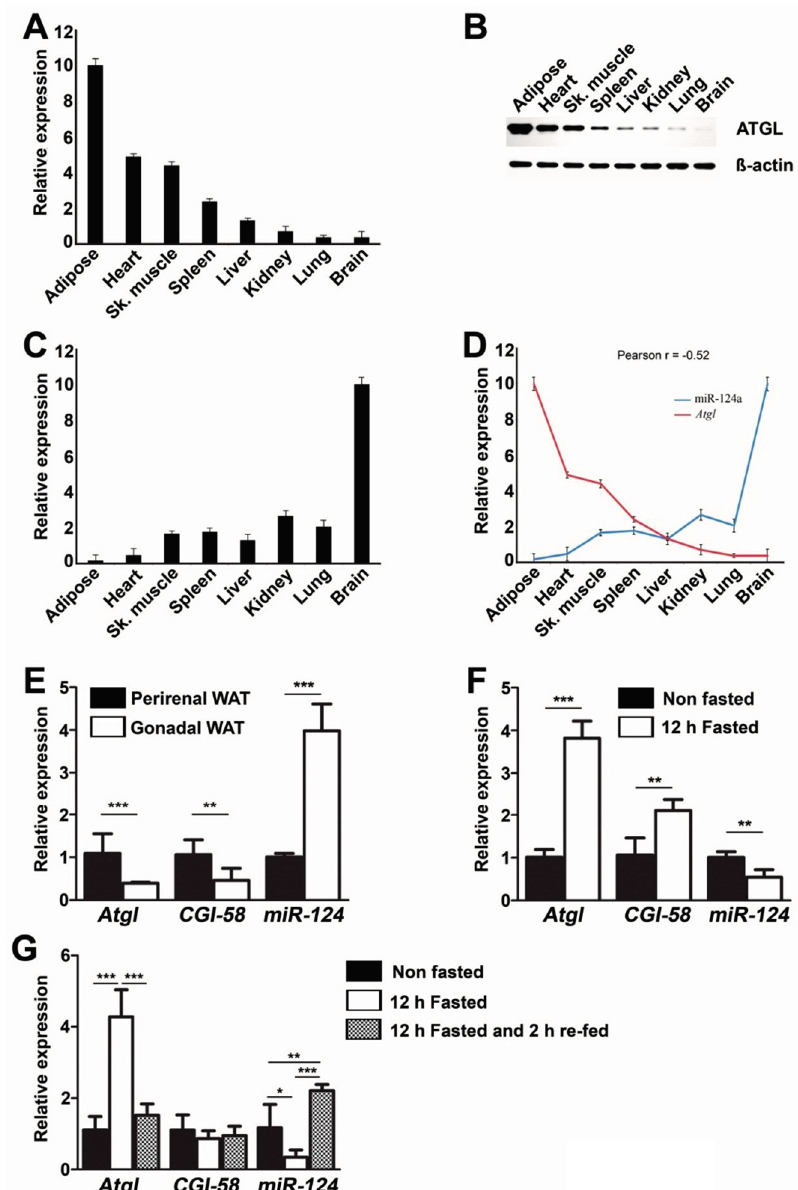
Figure 4. miR-124a expression negatively correlates to Atgl (mRNA) levels in various murine tissues. ( A , B ) Relative Atgl (mRNA) ( A ) and protein ( B ) expression measured in various murine tissues. Atgl (mRNA) level in adipose tissue arbitrarily set to 10; ( C ) Relative expression of mature miR-124a measured by qRT-PCR. Mature miR-124a level in brain arbitrarily set to 10; ( D ) Correlation between Atgl (mRNA) and miR-124a expression in various murine tissues; ( E ) Relative Atgl , Cgi-58 and miR-124a expression measured in murine perirenal as well as gonadal WAT; ( F ) Relative Atgl , Cgi-58 and miR-124a expression measured in murine perirenal WAT from ad libitum fed or, 12 h overnight fasted, mice; ( G ) Relative Atgl , Cgi-58 and miR-124a expression measured in murine liver from ad libitum fed or, 12 h overnight fasted or, 12 h overnight fasted and 2 h re-fed mice. Data are shown as average ± standard deviation and represent three independent experiments ( A – D ) or five independent experiments ( E – G ). *** p < 0.001, ** p < 0.01, * p <